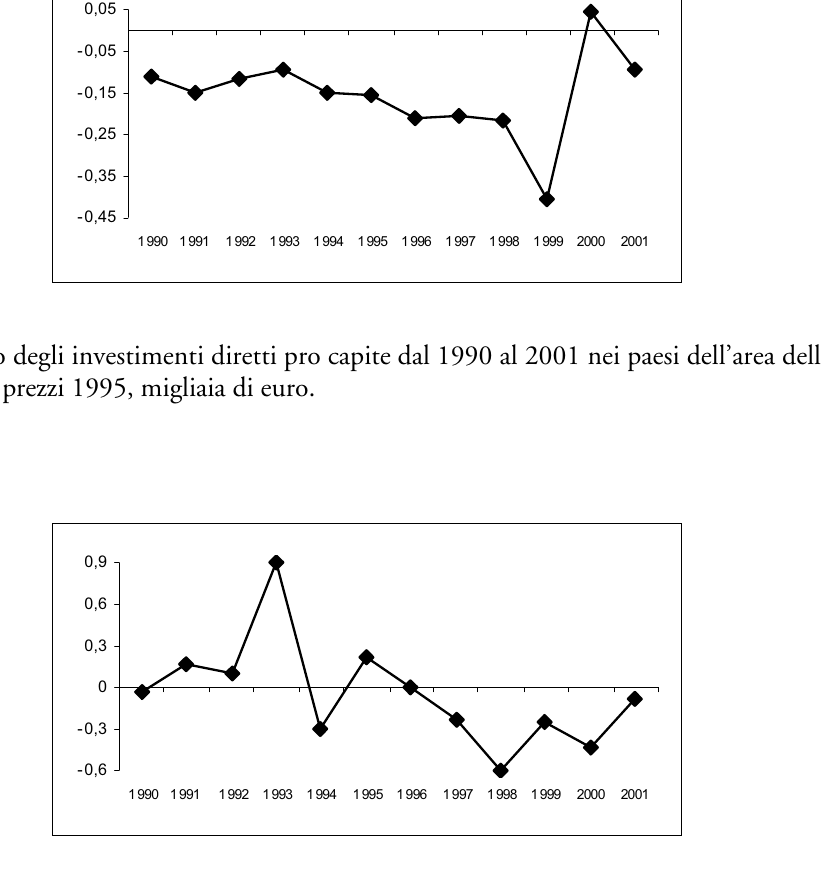
Figura 4 – Saldo degli investimenti di portafoglio pro capite dal 1990 al 2001 nei paesi dell’area dell’EURO – dati annuali a prezzi 1995, migliaia di